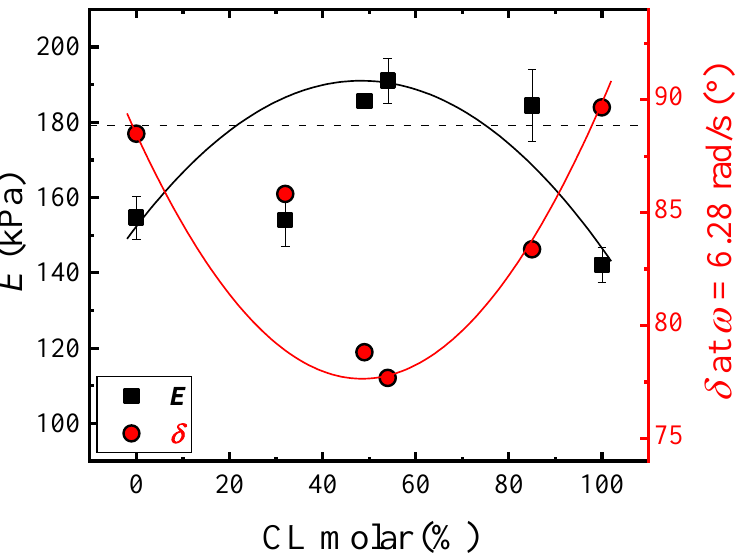
Figure 8. Tensile modulus E obtained at a debonding velocity of 0.314 mm/s ( ω = 6.28 s − 1 ) and phase angle δ obtained at ω = 6.28 rad/s, as a function of composition. The horizontal segmented line corresponds to the E value of the Valco adhesive. The solid lines are guides to the eye.